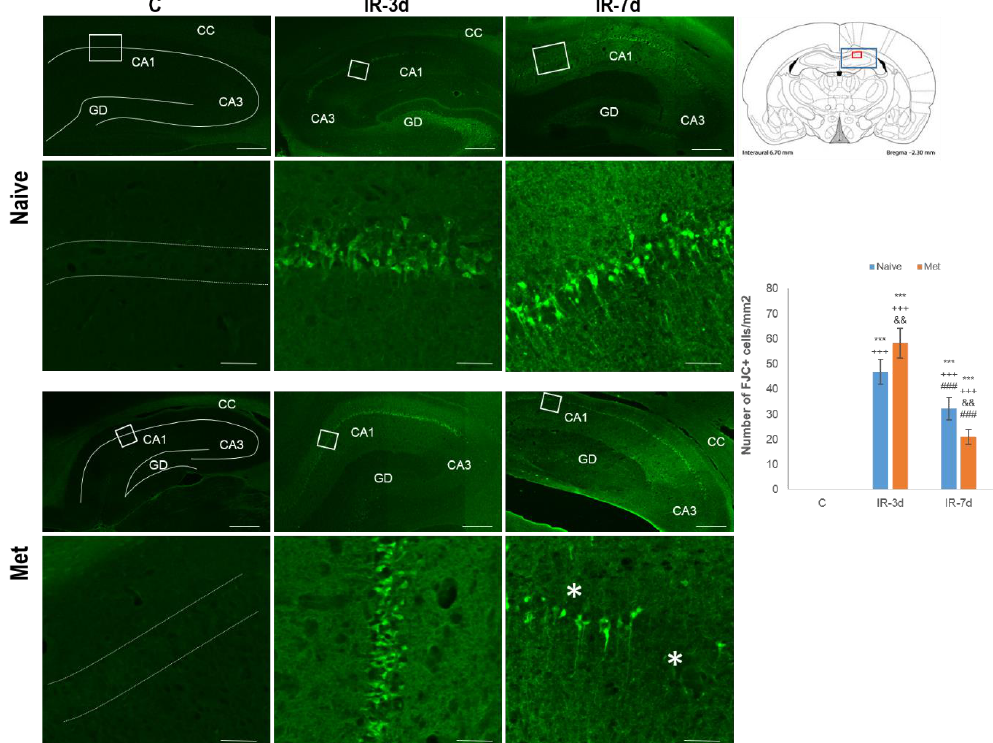
Figure 3. FluoroJade-C stained rat brain sections and statistical evaluation of the changes in the number of disintegrated neurons in the CA1 region of the hippocampus. The first line shows fluorescent low magnification micrographs of the rat hippocampus representing naïve control (C), naïve IR-3d and naïve IR-7d groups. The third line represents low-magnification fluorescent micrographs of the rat hippocampus of Met-C, Met-IR-3d and Met-IR-7d. Details of the corresponding group focusing on the CA1 region of the hippocampus are shown in lines two and four. Arrows indicate FJC+ neurons while arrowhead points at morphologically changed neurons. White squares in the first and third columns present area of magnification. An asterisk is placed at the area of neuronal breakdown. CC— corpus calosum , CA3— cornu ammonis 3, GD— gyrus dentatus . Bar = 500 and 50 µ m; n = 5 / group. Schematic coronal rat brain section (the upper right corner), redrawn according to Paxinos and Watson [26] poses hippocampus (blue rectangle) and smaller (red rectangle) detects CA1 area of rat hippocampus. The number of disintegrated neuronal cells in the CA1 area of the hippocampus (the middle right corner) in the naïve control, Met-C, IR-3d, Met-IR-3d, IR-7d and Met-IR-7d. Results are presented as mean ± standard deviation (SD), n = 5 / group. *** p < 0.001 versus the control value; +++ p < 0.001 versus the Met-C, && p < 0.01 versus the groups with the same reperfusion period with / without Met diet pre-treatment, ### p < 0.01 versus IR-3d with / without Met